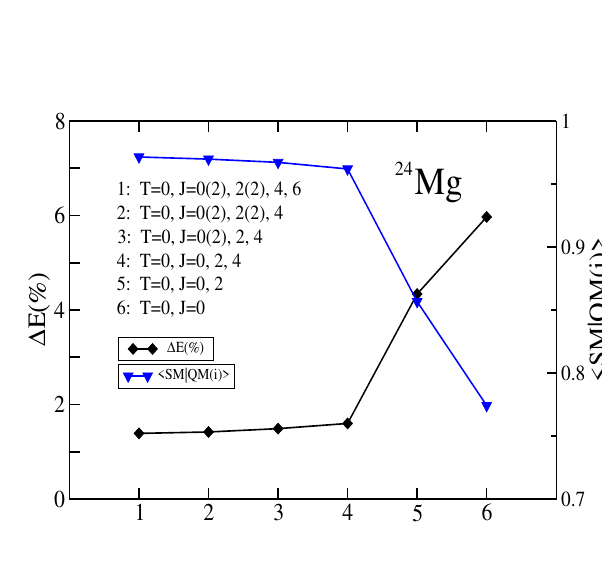
Figure 2. Relative errors (with respect to the SM value) in the ground state correlation energy of 24 Mg obtained within the QM with the sets of quartets indicated in the figure. For each set we also show the overlaps between SM and QM wave